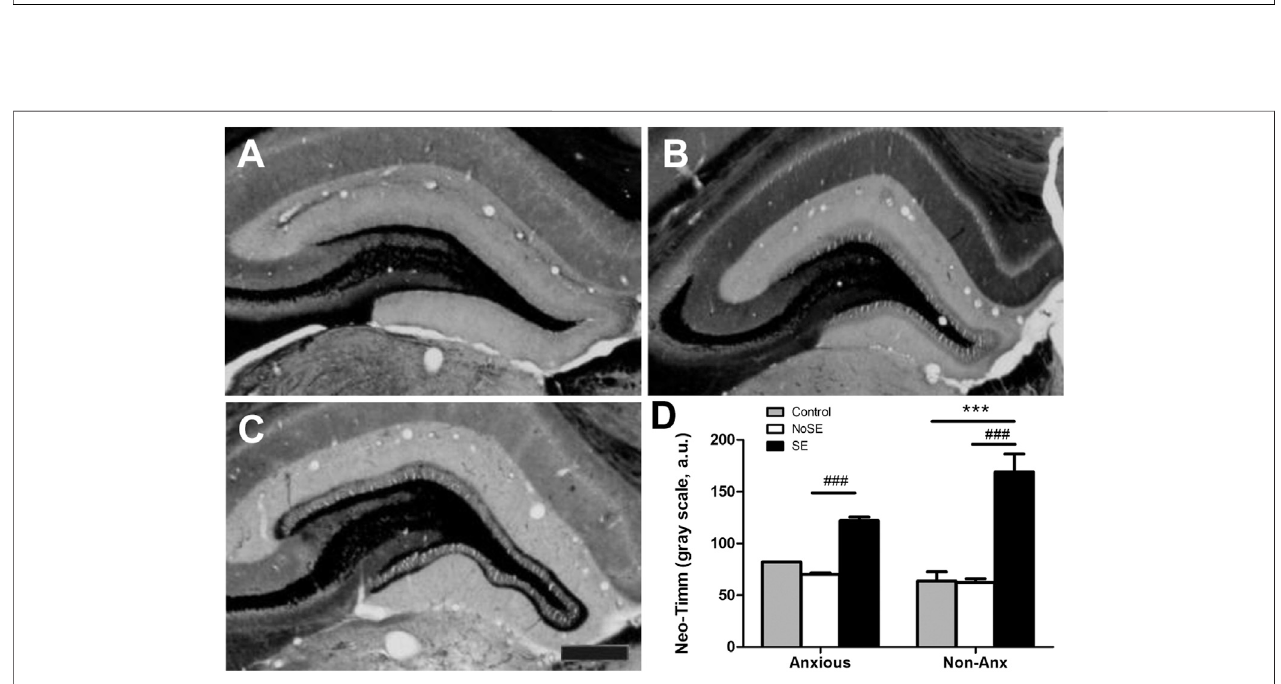
FIGURE9| PhotomicrographsofNeo-Timmstaininginthehippocampaldentategyrus. (A) Control (B) NoSE (C) SEanimal.NoteslightlyincreaseofTimmstaining in NoSE animals and evident darker staining, especially at the inner molecular layer of the dentate gyrus in SE animals. (D) Densitometry analysis of the inner molecular layer con fi rmed increased Neo-Timm intensity in SE animals and no in fl uence of the anxiety level on mossy fi ber sprouting. Values: mean ± SEM. Two-Way ANOVA, Bonferroni post hoc test, p < 0.05 SE groups *vs Controls, # vs NoSE. Scale bar: 50 μ m.